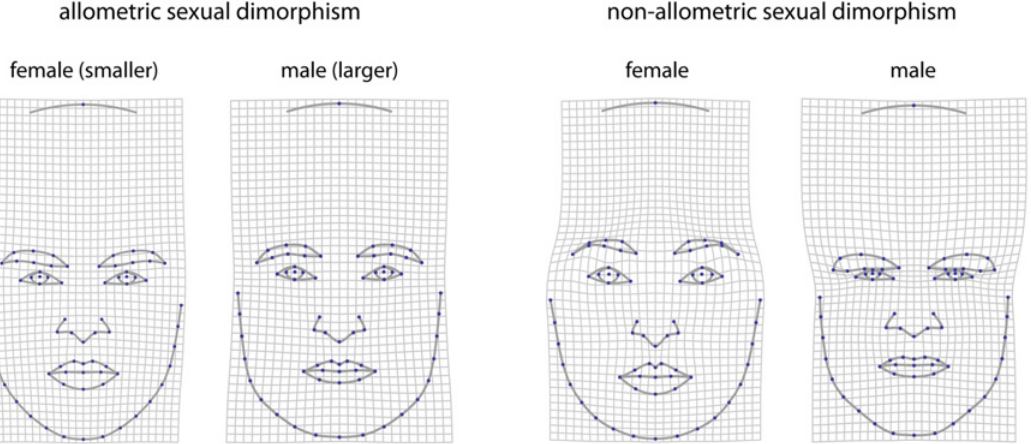
Fig 5. Decomposition of sexual dimorphism into an allometric and a non-allometric component. The corresponding deformation grids are two-fold extrapolations of the actual